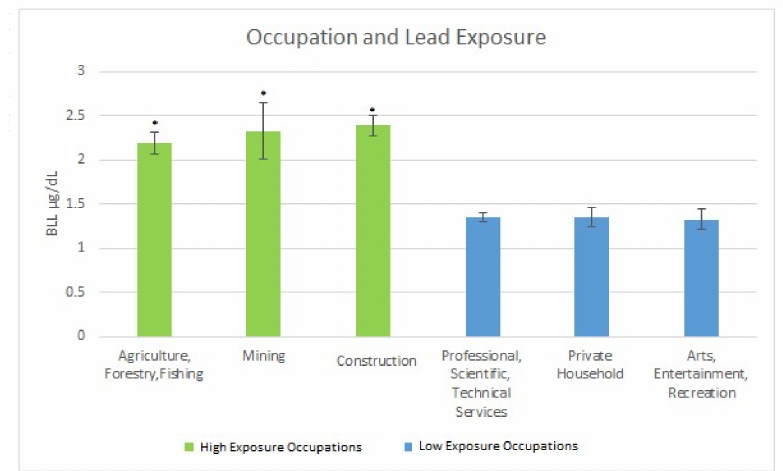
Figure 1. Occupation and Lead Exposure. * Significant difference between high exposure occupations as compared to low exposure occupations.